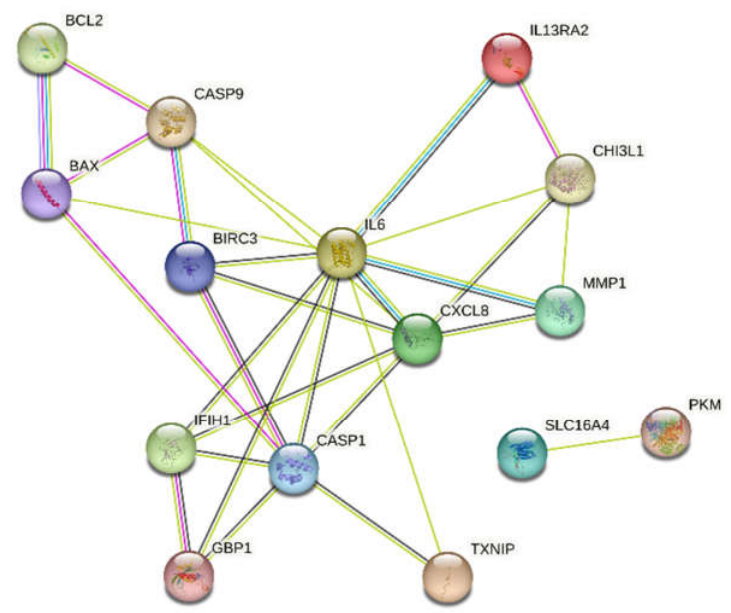
Figure 7. Protein–protein interaction network generated using the STRING database. STRING database—Search Tool for the Retrieval of Interacting Genes/Proteins.